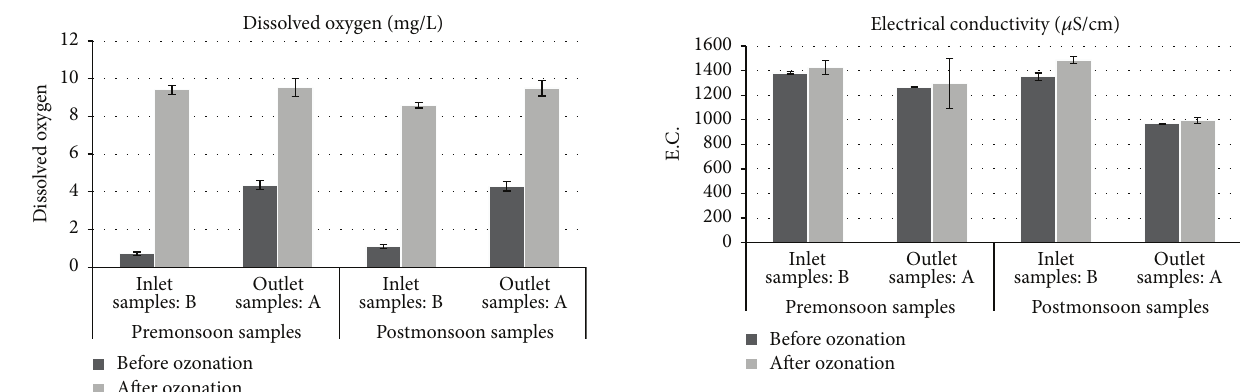
Figure 6: Electrical conductivity of inlet and outlet samples before and after treatment by ozone.